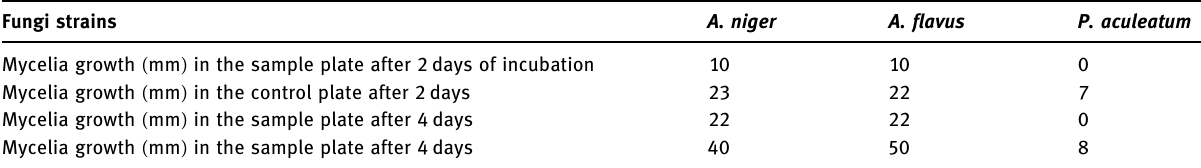
Table 3: Mycelia growth ( mm ) of three di ff erent fungi strains, in the plates containing ZnO NPs and control plates Fungi strains A.